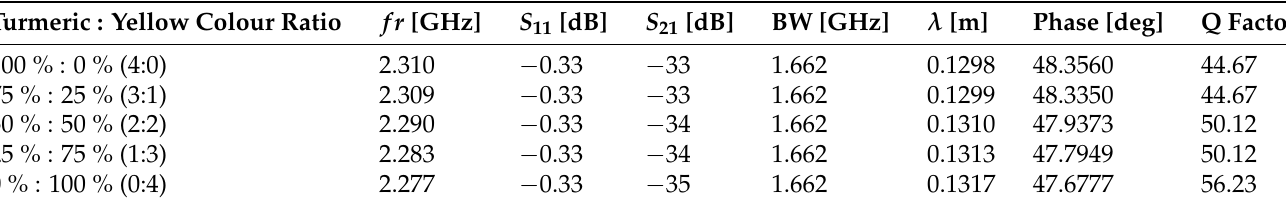
Table 9. Adulteration testing in